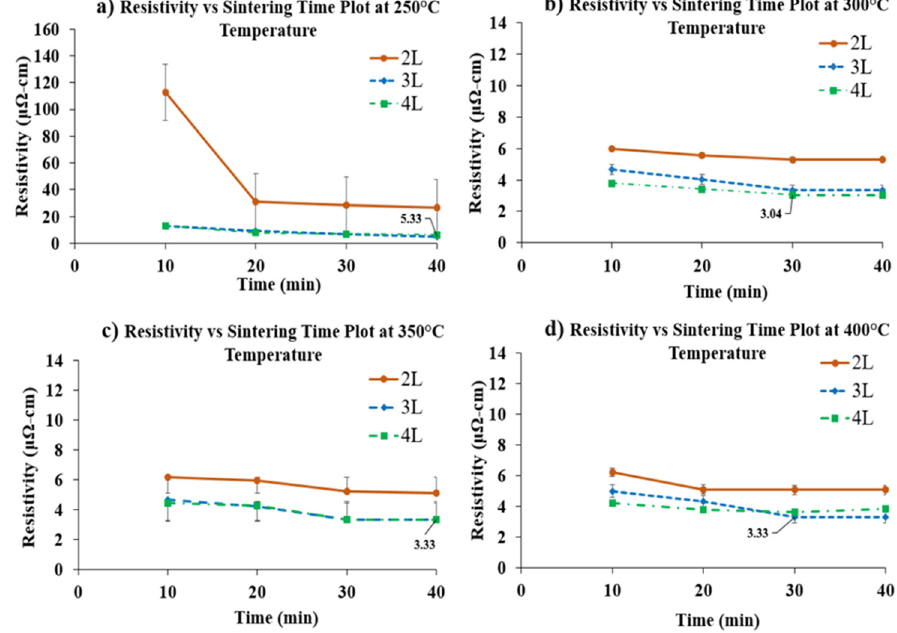
Figure 4. Resistivity value as a function of sintering time at different sintering temperatures: ( a ) 250 °C, ( b ) 300 °C, ( c ) 350 °C, ( d ) 400 °C.